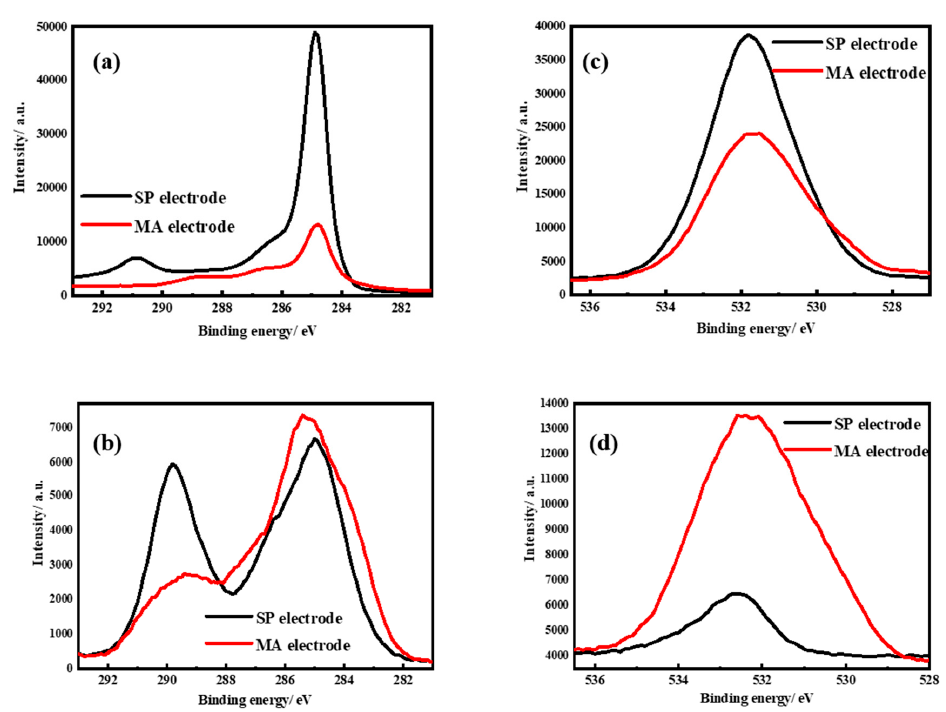
Figure 5. The XPS of C1s spectra of two electrodes ( a ) before charge and ( b ) after 50 cycles. The O1s spectra of two electrodes ( c ) before charge and ( d ) after 50 cycles.